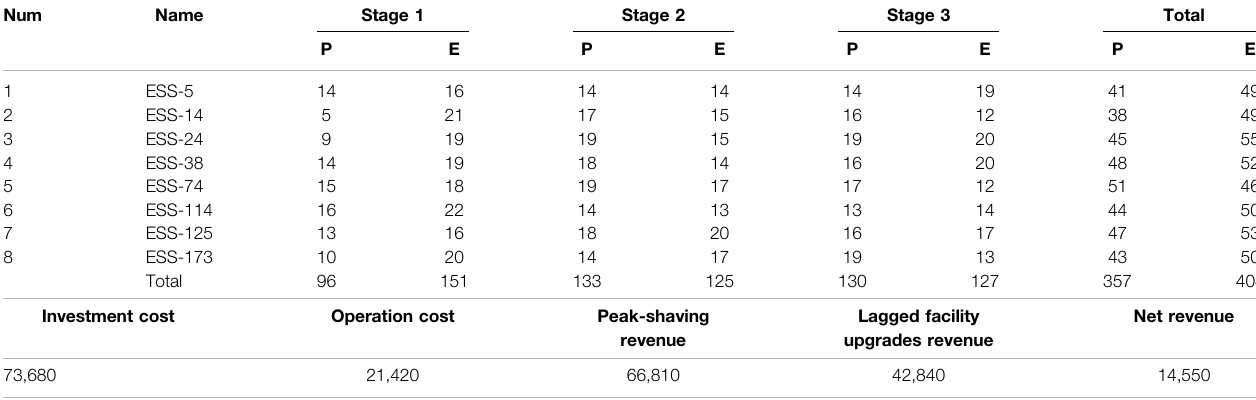
TABLE 1 | Energy storage system planning results of each stage of case I. Num